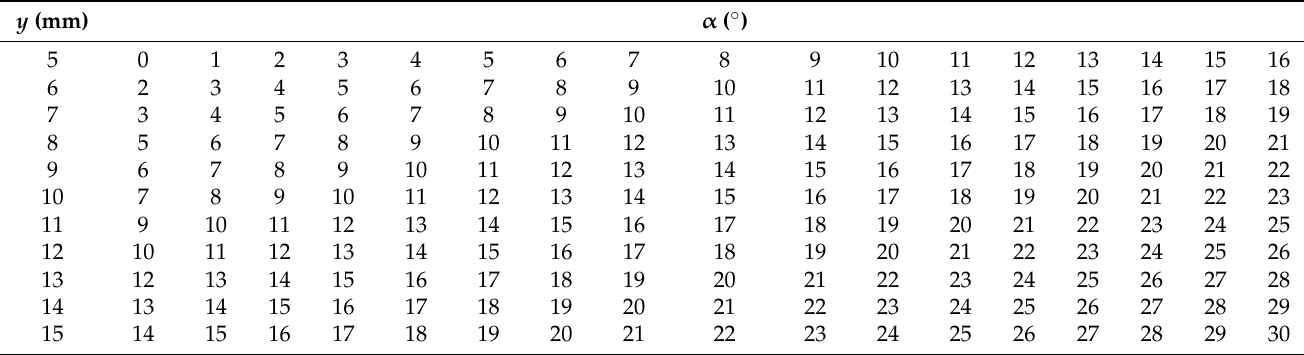
Table 1. Different combinations between y and α